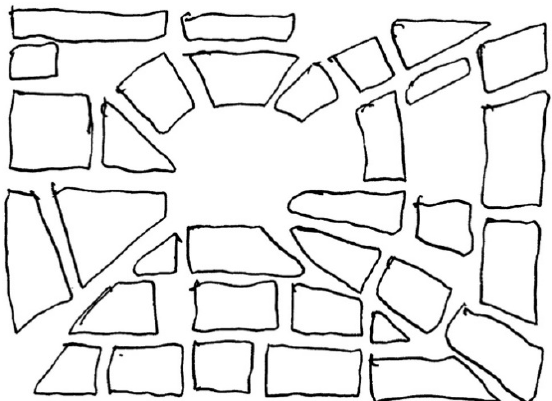
Figure 2. Roughly radial plan with a good distribution of urban spaces, where building footprints adapt to the street flows instead of sacrificing the urban space to maintain some imaginary abstract plan for the buildings’ position.